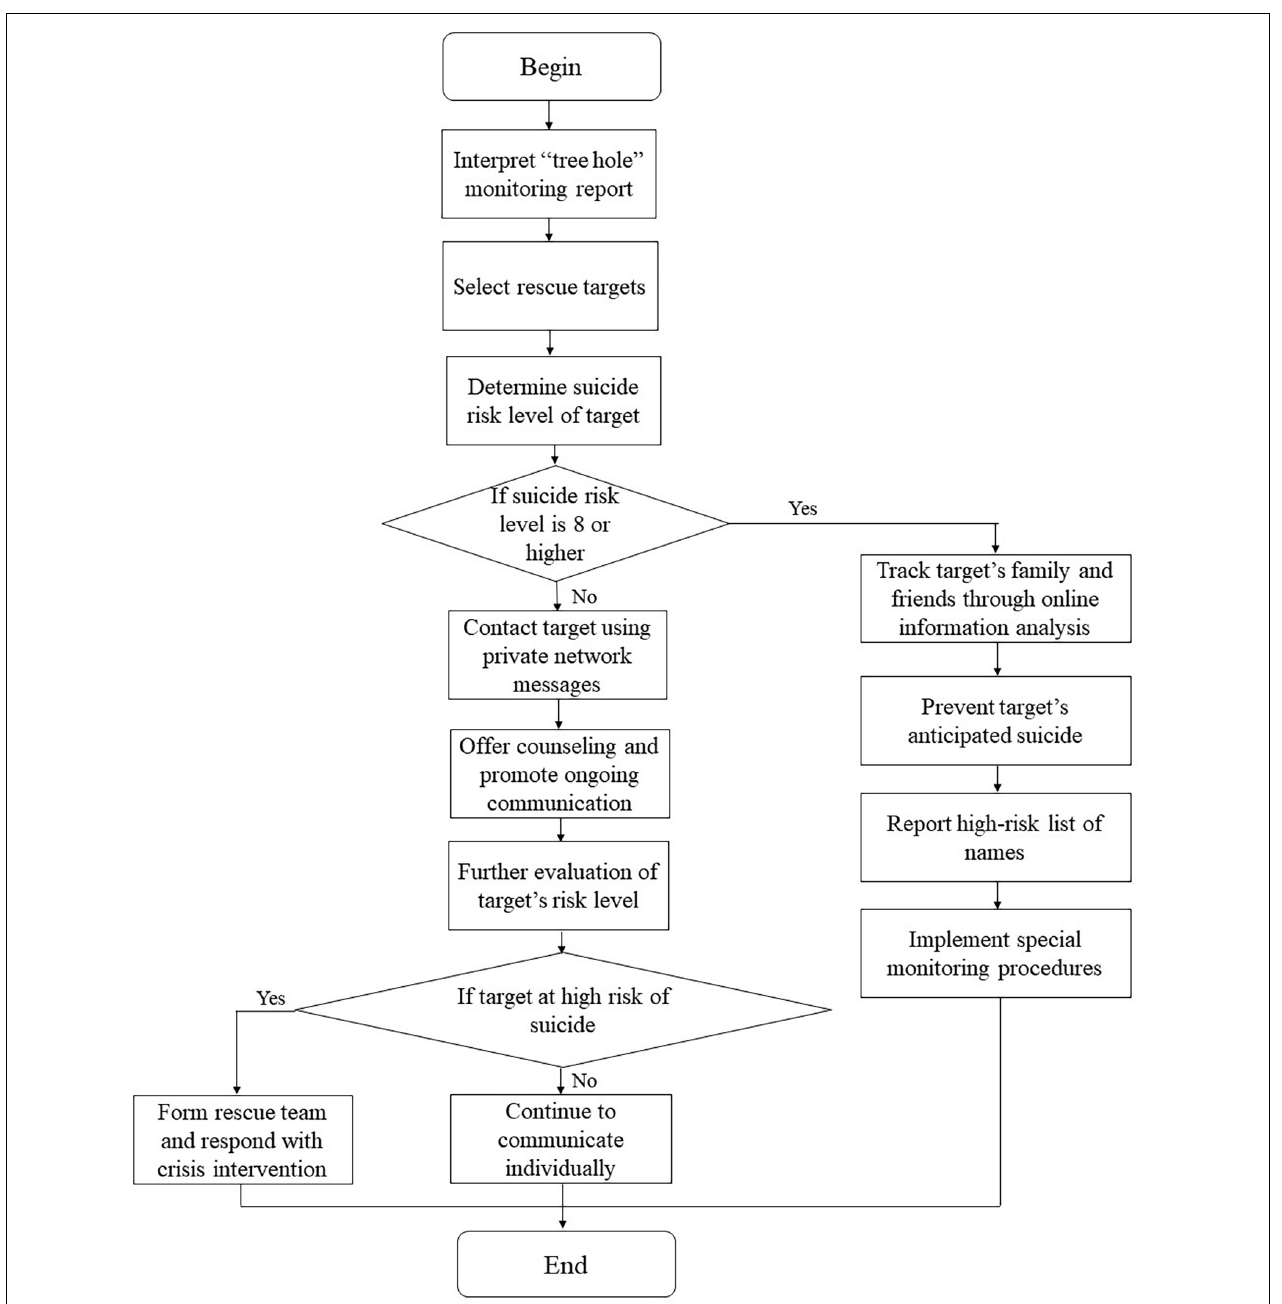
FIGURE 2 | Procedure of “Tree Hole